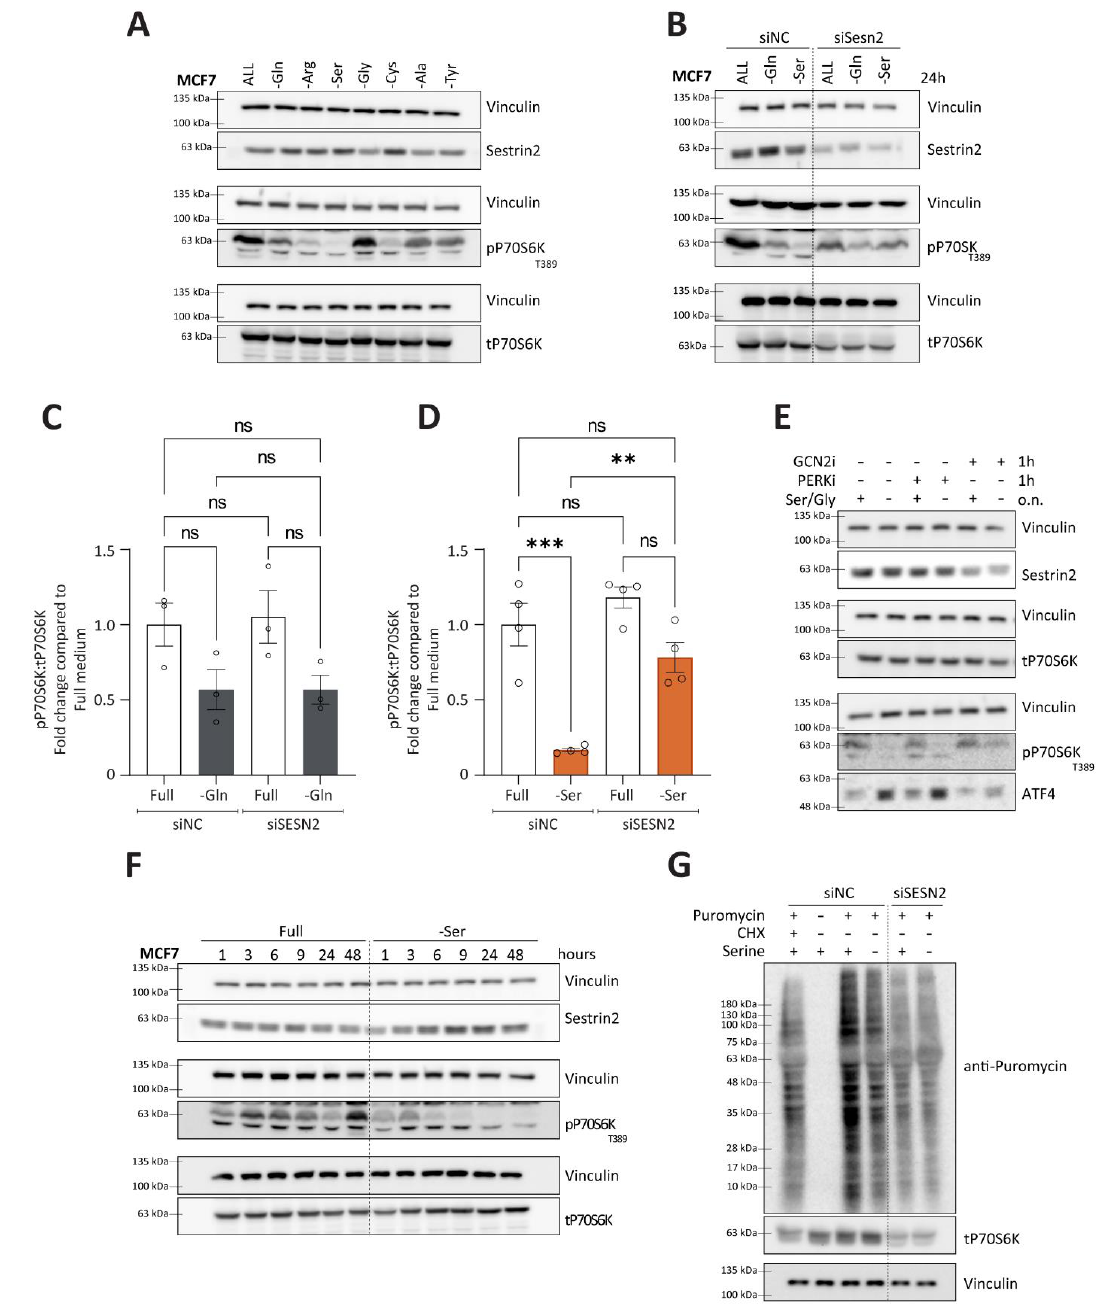
Figure 6. Sestrin2dependent regulation of mTORC1 upon amino acid deprivation. ( A ) Sestrin2 protein levels and phosphorylation of P70S6K after two days of amino acid deprivations; ( B ) phosphorylation of P70S6K upon SESN2 silencing in the presence or absence of indicated amino acids; ( C , D ) densitometric quantification of Western blots from three independent experiments in MCF7 cells (n = 3). ANOVA with a post hoc Tukey test was used to measure statistical significance; ( E ) Sestrin2, ATF4 levels, and the phosphorylation of P70S6K in MCF7 cells upon the cotreatment with GCN2 inhibitor (1 µM) and PERK inhibitor (1 µM) in either the presence or absence of serine (0.4 mM), glycine (0.4 mM), or in combination; ( F ) timedependent regulation of Sestrin2 and phosphorylation of P70S6K upon the serine deprivation; ( G ) protein synthesis in MCF7 cells measured with puromycin (90 µ M) with CHX (20 µ M) as a positive control upon siNC or siSESN2. Samples were re-probed for the vinculin control. Dots represent individual values. ** and *** indicate p ≤ 0.01 and 0.001, respectively. n.s. indicates statistical